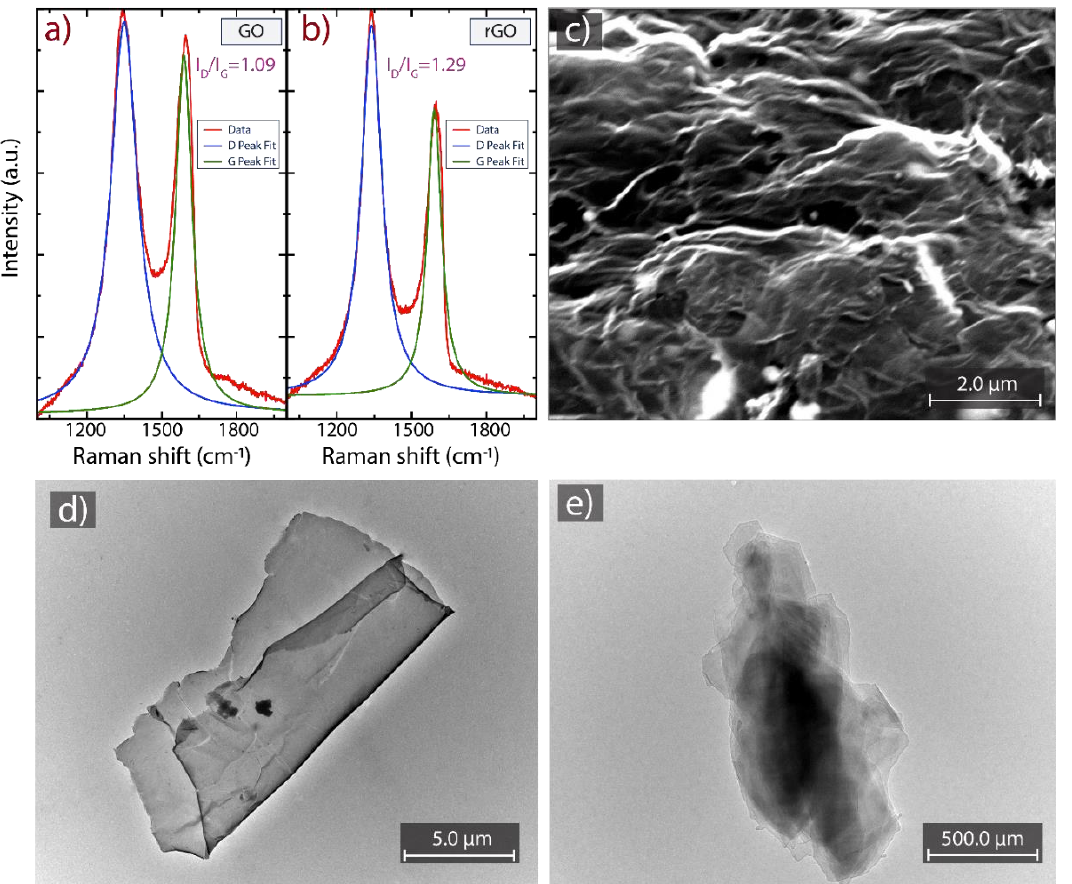
Figure 3. ( a , b ) Raman spectra recorded using 532 nm laser excitation. The intensity was normalized by the D peak. ( c ) SEM morphology of rGO. TEM images of ( d ) GO and ( e ) rGO.